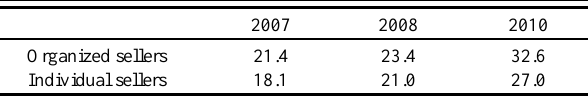
Table 2 . Average selling prices for organized and individual ejido's coffee producers. Based on our fieldwork data. Prices are in Mexican pesos per kilo.